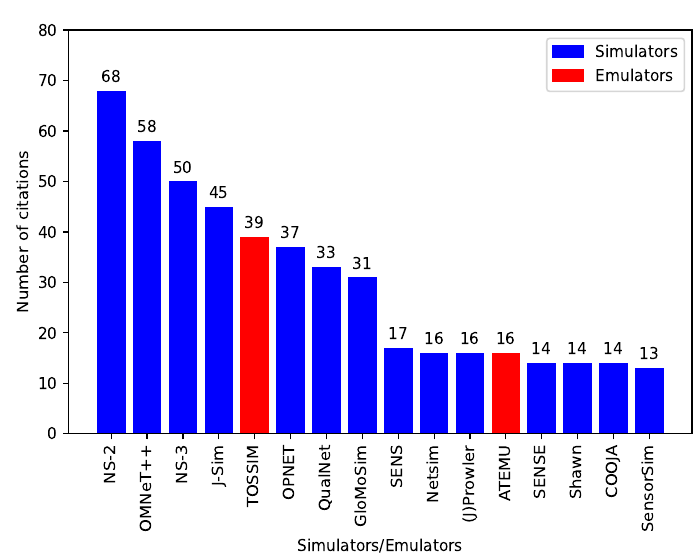
Figure 1. Yearly distribution of selected papers.